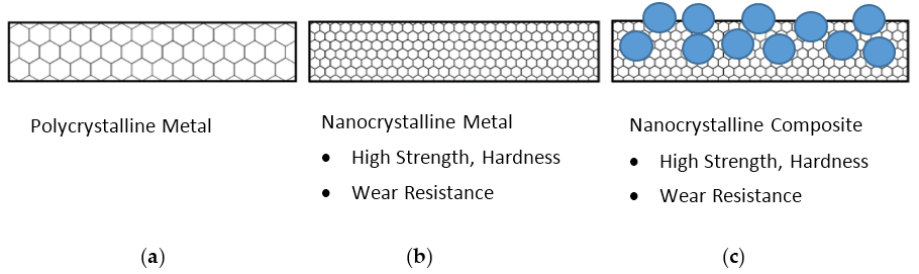
Figure 8. Schematic cross-sectional diagram of various electrodeposits: ( a ) polycrystalline metal; ( b ) nanocrystalline metal with a high density of grain boundaries; ( c ) nanocrystalline metal matrix composite with hydrophobic particles.